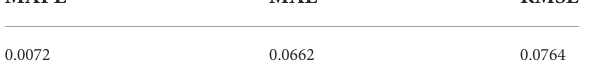
TABLE 2 Model ef fi ciency summary. MAPE